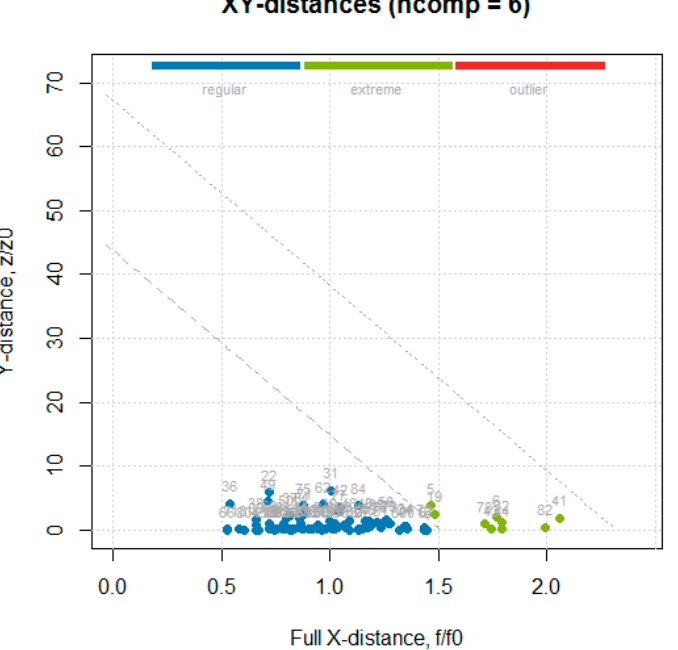
Figure 15. Distance (residual) plot with normalized orthogonal and score distances of the TSS model built using a classic approach for computing the critical limits. Two prediction models were built, one using all spectra and another byremoving the PCA detected outliers (Table 4 and Figure 16). Since the removal of the extreme values did not lead to any improvement in the prediction model, those spectra were not removed. Table 4. PLS model (class pls) summary for the TSS data.